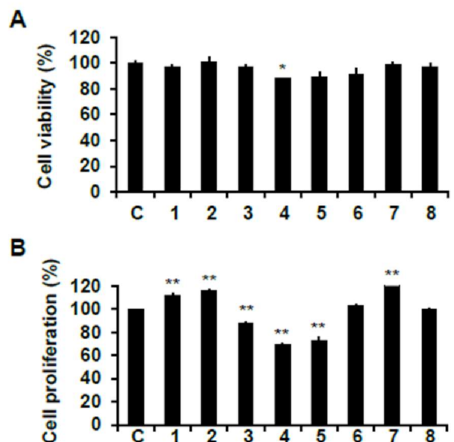
Figure 6. Skeletal muscle cell proliferation activities of phytochemicals from Chinese chive on C2C12 cells. ( A ) Cytotoxicity of phytochemicals on C2C12 cells. Cells were incubated for 24 h after seeding, and then treated phytochemicals for 24 h. After, MTT assay was performed. ( B ) Cell proliferation activity of phytochemicals on C2C12 cells. Cells were incubated for 48 h after seeding, and phytochemicals were treated while being replaced with three differentiation medium during six days of the differentiation period. After the differentiation period, cell proliferation activity was measured using BrdU assay. C, control. Experiments were performed in triplicate and the data were expressed as mean ± SE; * p < 0.01, ** p < 0.01 as compared to the control (untreated